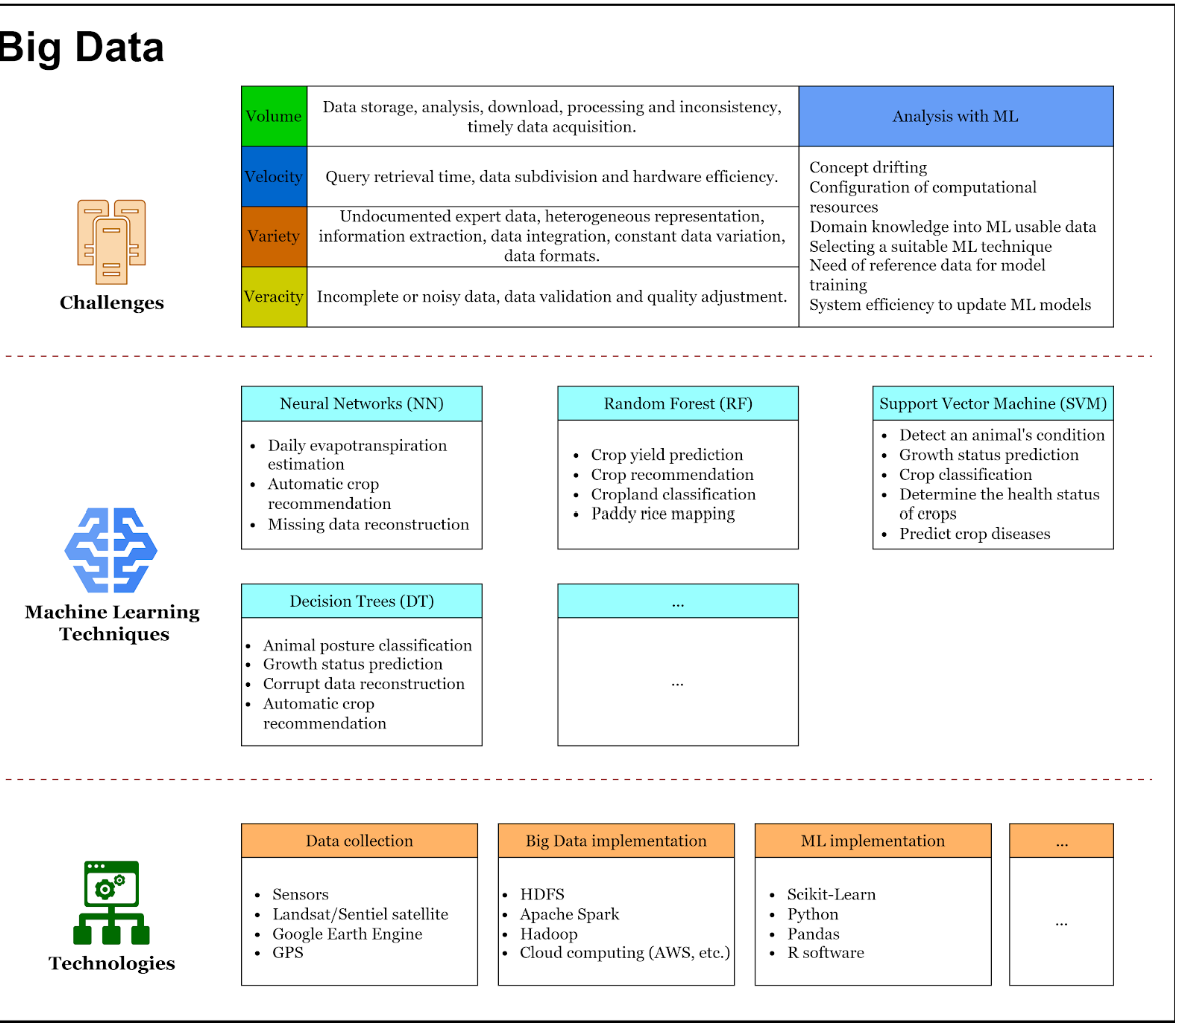
Figure 15. Framework—main ML challenges in agricultural Big